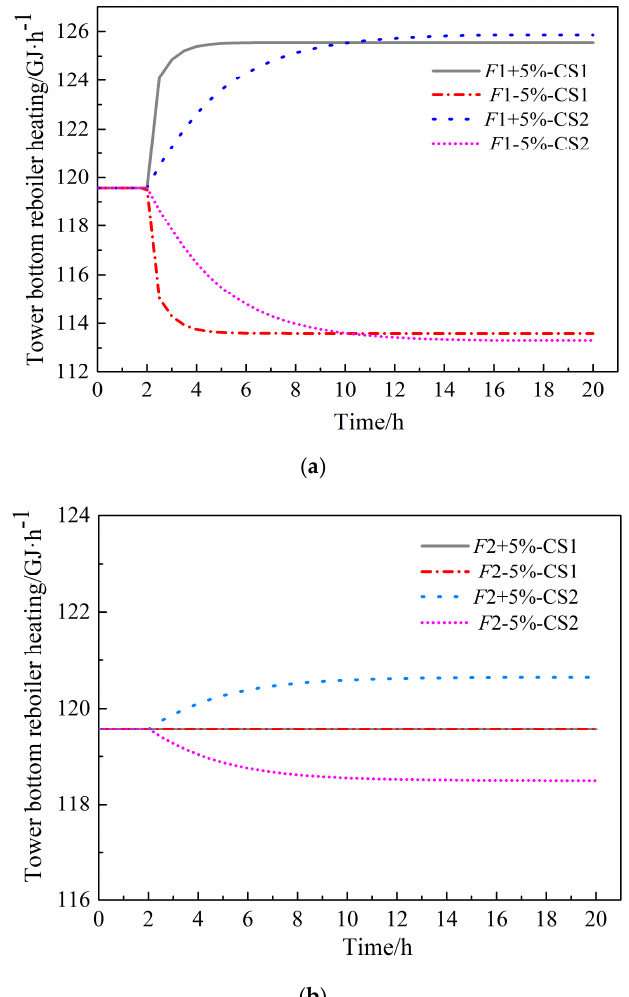
Figure 13. The control response of CS1 CS2 to the heating of the column boiler reboiler. ( a ) Response to disturbance in feed F1 and ( b ) response to disturbance in feed F2.